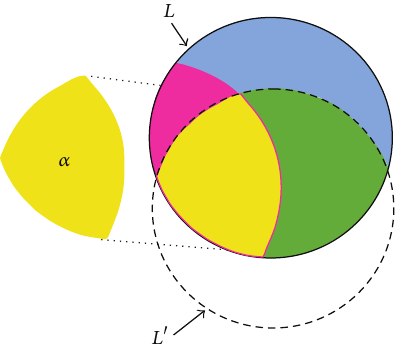
Figure 4: The set of sensitive itemsets that fail to be hidden.